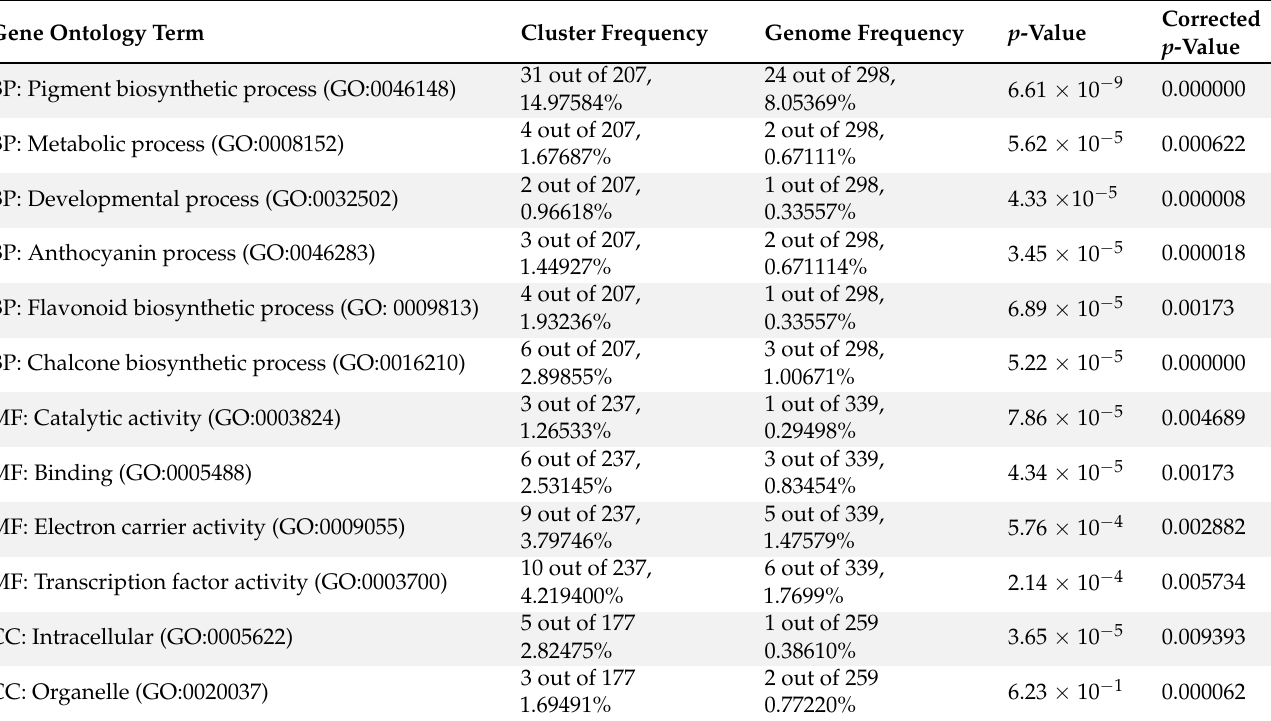
Figure 5. ( A ) The differentially expressed genes (DEGs) studied using RNA-Seq analysis during the colour development stages of Hydrangea macrophylla . ( A ) Venn diagram of the DEGs in three comparisons (CS1 vs. TS1, CS2 vs. TS2, and CS3 vs. TS3, respectively). ( B ) Vertical bar graph represents the number of up- (Blue boxes) and down- (purple boxes) regulated DEGs (FDR adjusted p -value cut-off of ≤ 0.05) based on their fold changes between the different stages. Table 2. Functional enrichment analysis of DEGs in hydrangea sepal’s transcriptome using Gene